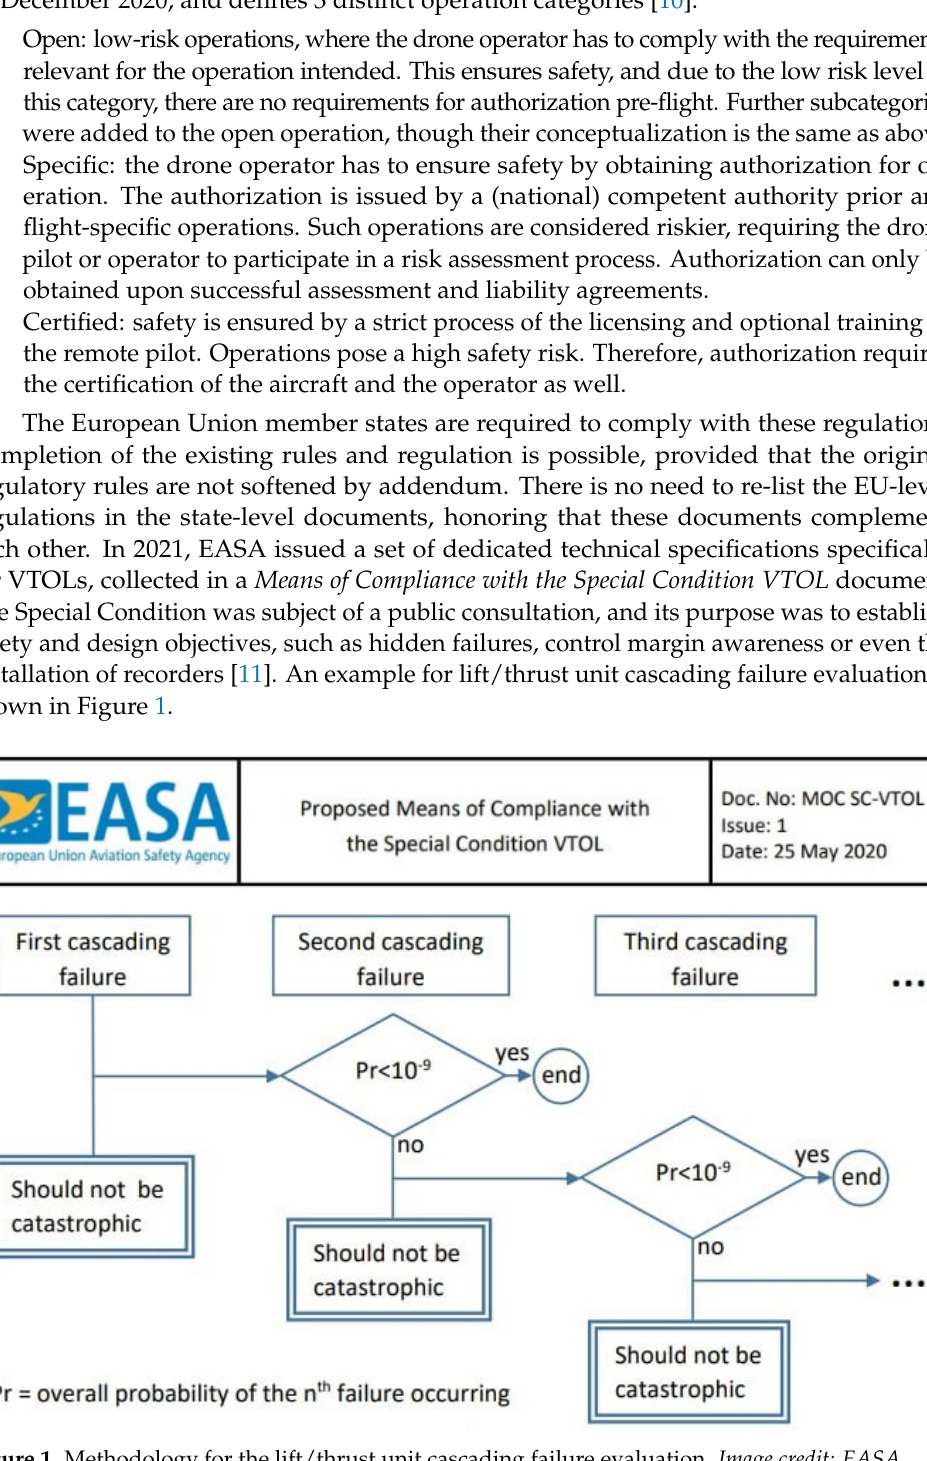
Figure 1. Methodology for the lift/thrust unit cascading failure evaluation. Image credit: EASA